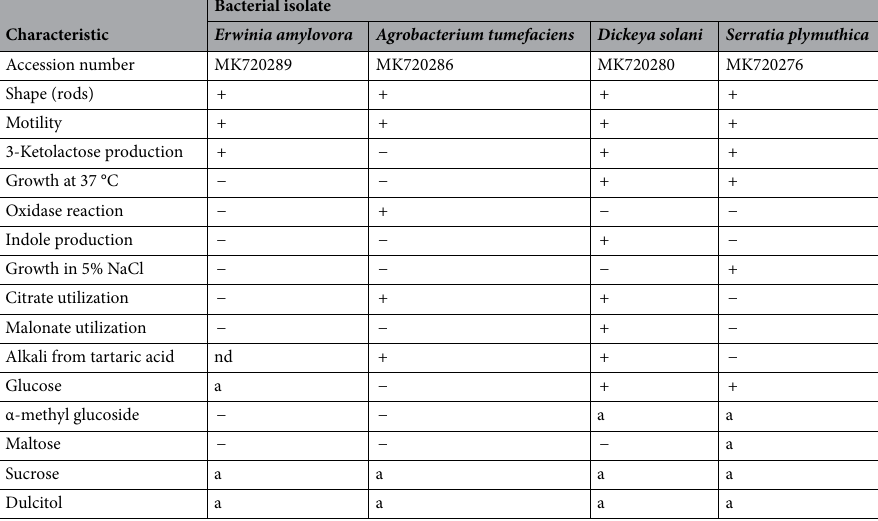
Table 5. Morphological, physiological, biochemical characteristics, and accession numbers of bacterial isolates retrieved from infected plants. + = More than 80% of isolates gave a positive reaction. − = Less than 20% of isolates gave a negative reaction. A acid, nd not determined.